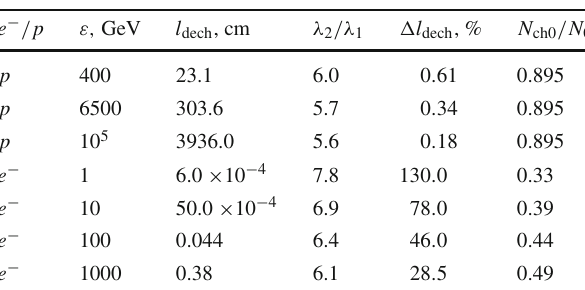
Table 2 Dechanneling lengths for protons and electrons of different